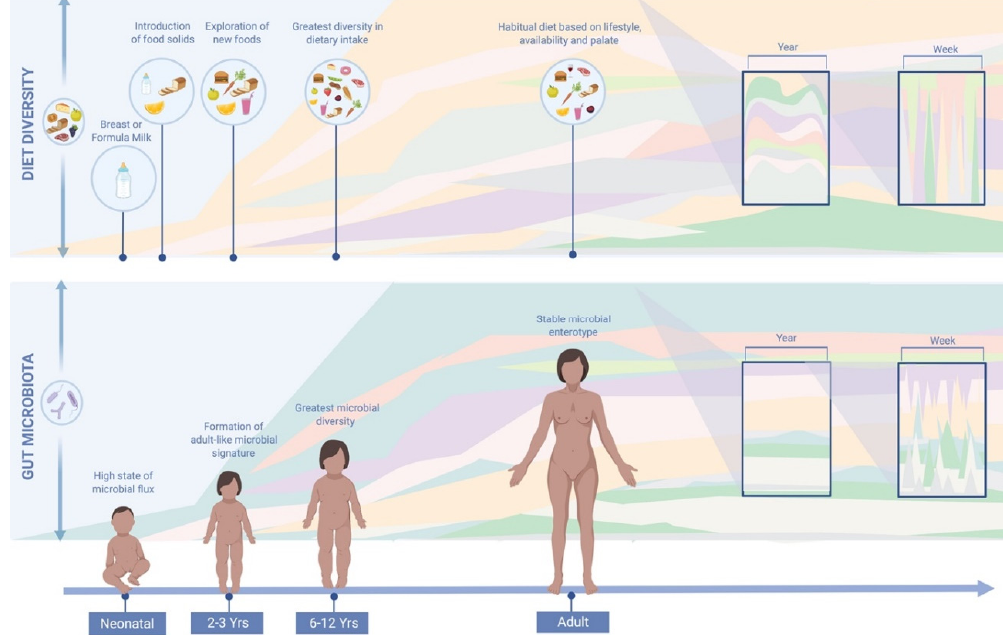
Figure 1. Comparison of diet and gut microbiota variations throughout life. Habitual diet plays a role in shaping the gut microbial environment, and hence, microbial composition. Dietary diversity has been associated with microbial diversity [78]. Throughout the year, the human diet tends to display a cyclical seasonal pattern due to seasonal availability and dietary preferences. Large day to day variations in diet are not reflected in the gut microbiota, suggesting that overall dietary habits have a greater impact on gut microbial composition [35]. This image was generated using BioRender Software (http://www.biorender.com/).